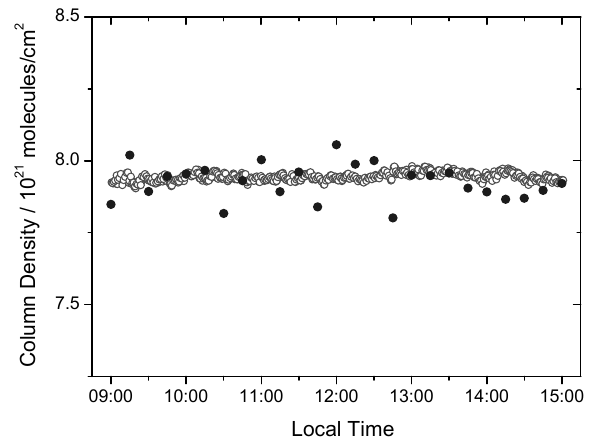
Fig. 13 Fig. 13. CO 2 column density measured by FFPI on 31 October 2009 at the Katsura Campus of Kyoto University, Kyoto Japan. Open circles are the CO 2 column densities after normalization and the solid circles are those measured by OSA at the same